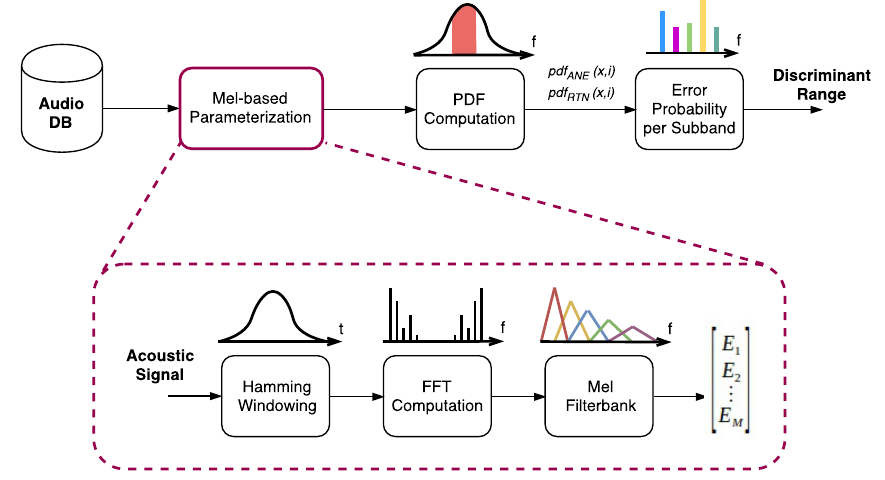
Figure 3. Block diagram of the process conducted to select a frequency range with minimum probability of error of